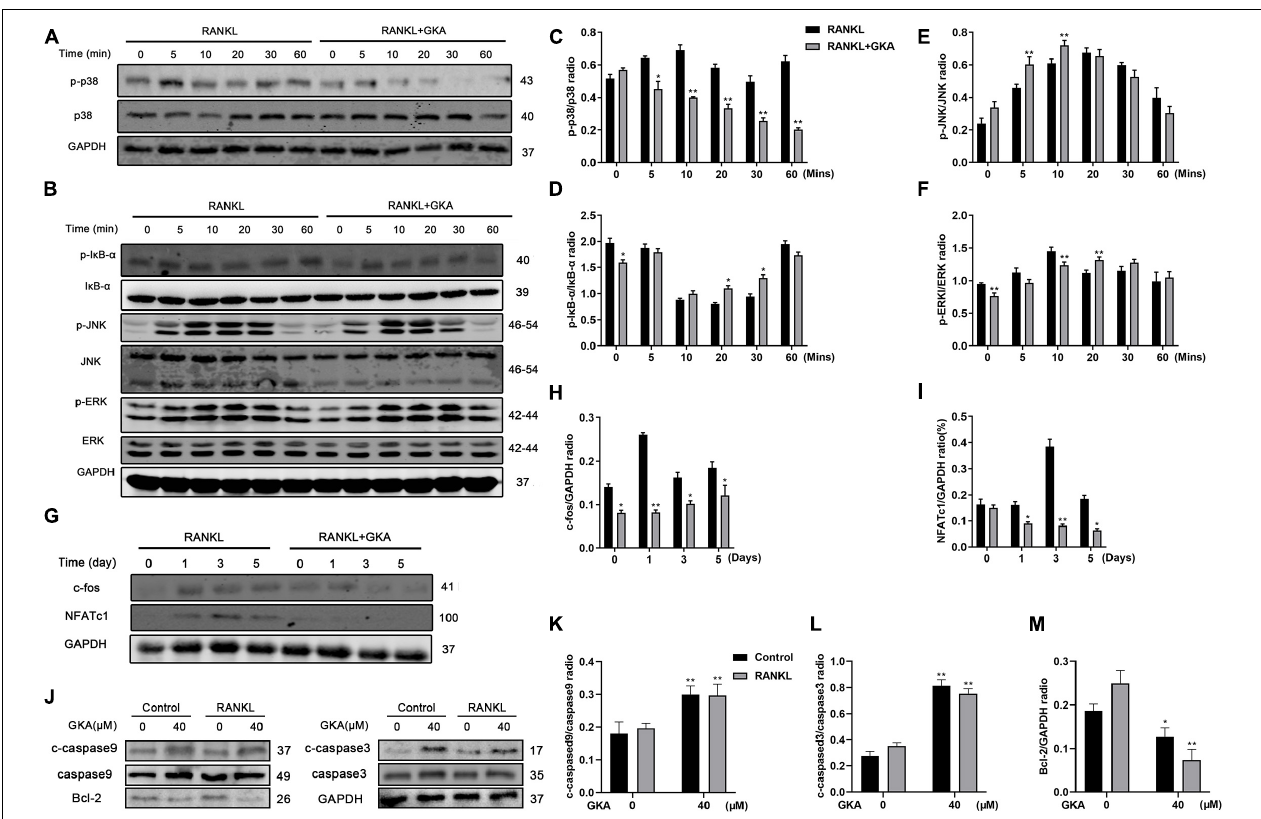
FIGURE 4 | GKA suppressed RANKL-induced p38/c-Fos/NFATc1 and apoptosis signaling pathways. (A,B) Representative images of the effects of 5 µ M GKA on RANKL-induced p38, I κ B- α , JNK, and ERK phosphorylation. (C–F) Quantification of the phosphorylated p38, p-I κ B- α , p-JNK, p-ERK relative to total p38, I κ B- α JNK, and ERK. (G) Representative images of effects of 5 µ M GKA on RANKL-induced c-fos and NFATc1 for a specific period of time. (H,I) Quantification of the radio of NFATc1 and c-Fos relative to GAPDH. (J) Representative images of the effects of 40 µ M GKA on caspase3, caspase9, and Bcl-2 for 48 h. (K–M) Quantification of the radio of cleaved caspase3 and cleaved caspase9 relative to total caspase3 and caspase9 or Bcl-2 relative to GAPDH. The data were presented as the mean ± SD (* P < 0.05, ** P < 0.01, analyzed by t -test; n = 3).